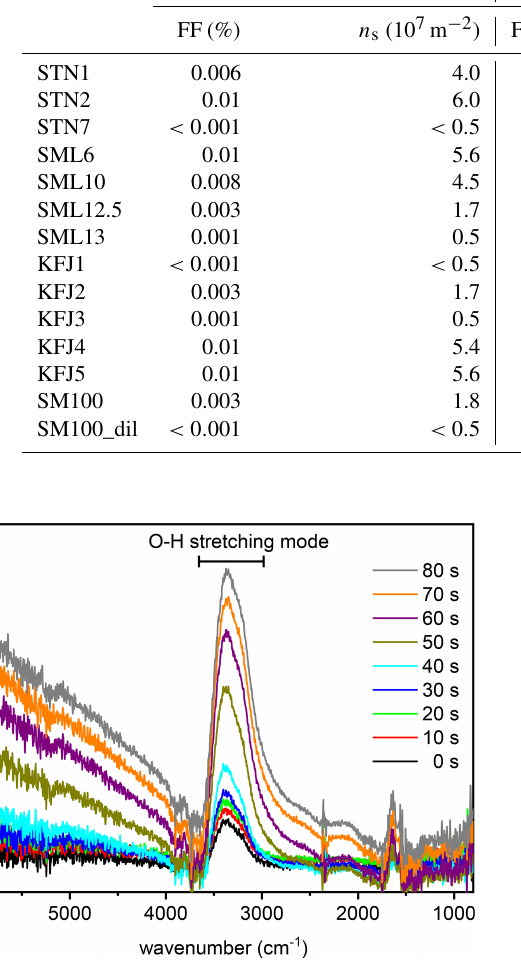
Figure 4. Series of infrared extinction spectra that were recorded in the first 80s during the expansion run with the particles gener- ated from the SM100 culture (see Fig. 3b). The broad peak between about 3500 and 2800cm − 1 is due to the O–H stretching mode of liquid water. As described in the text, this spectra series is represen- tative of all measurements with the various samples and is therefore also used to discuss the hygroscopic behaviour of the particles from the bulk Atlantic water sample in Sect.